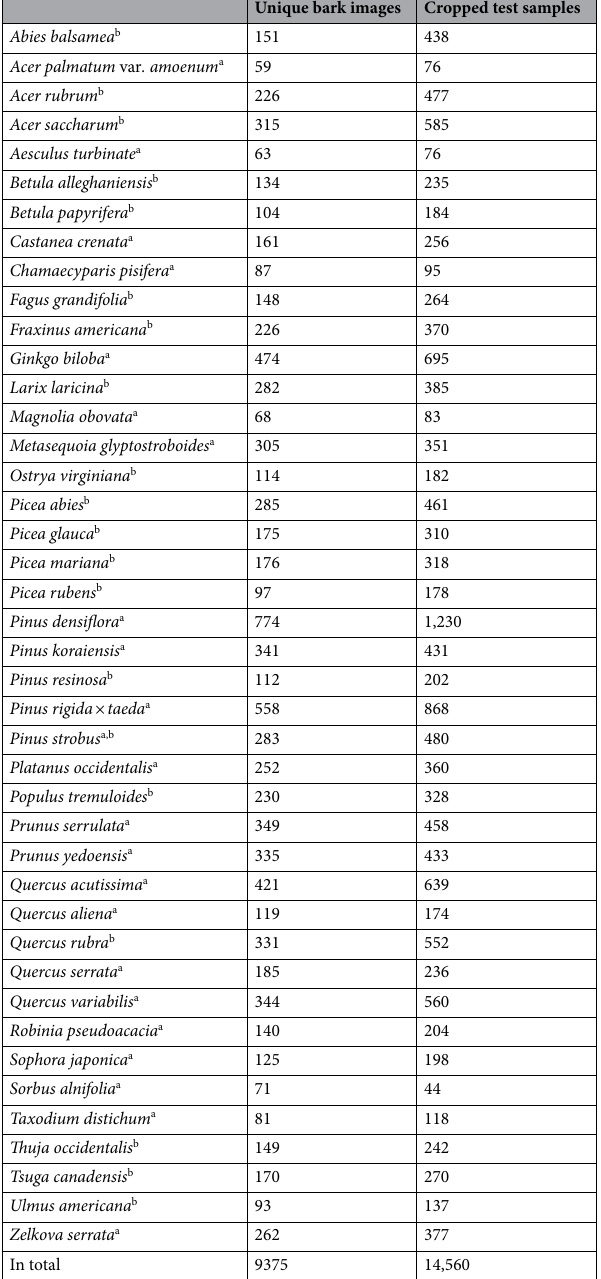
Table 2. Details of the tree species and corresponding number of bark images utilized in this study. Only the number of cropped test samples are described because we concurrently generated train samples during the training phase (see “Data pre-processing and augmentation”), rather than making the cropped samples from the prior train dataset. Superscripts a and b denote the source of the images; a represents the data collected in this study, and b from BarkNet 1.0